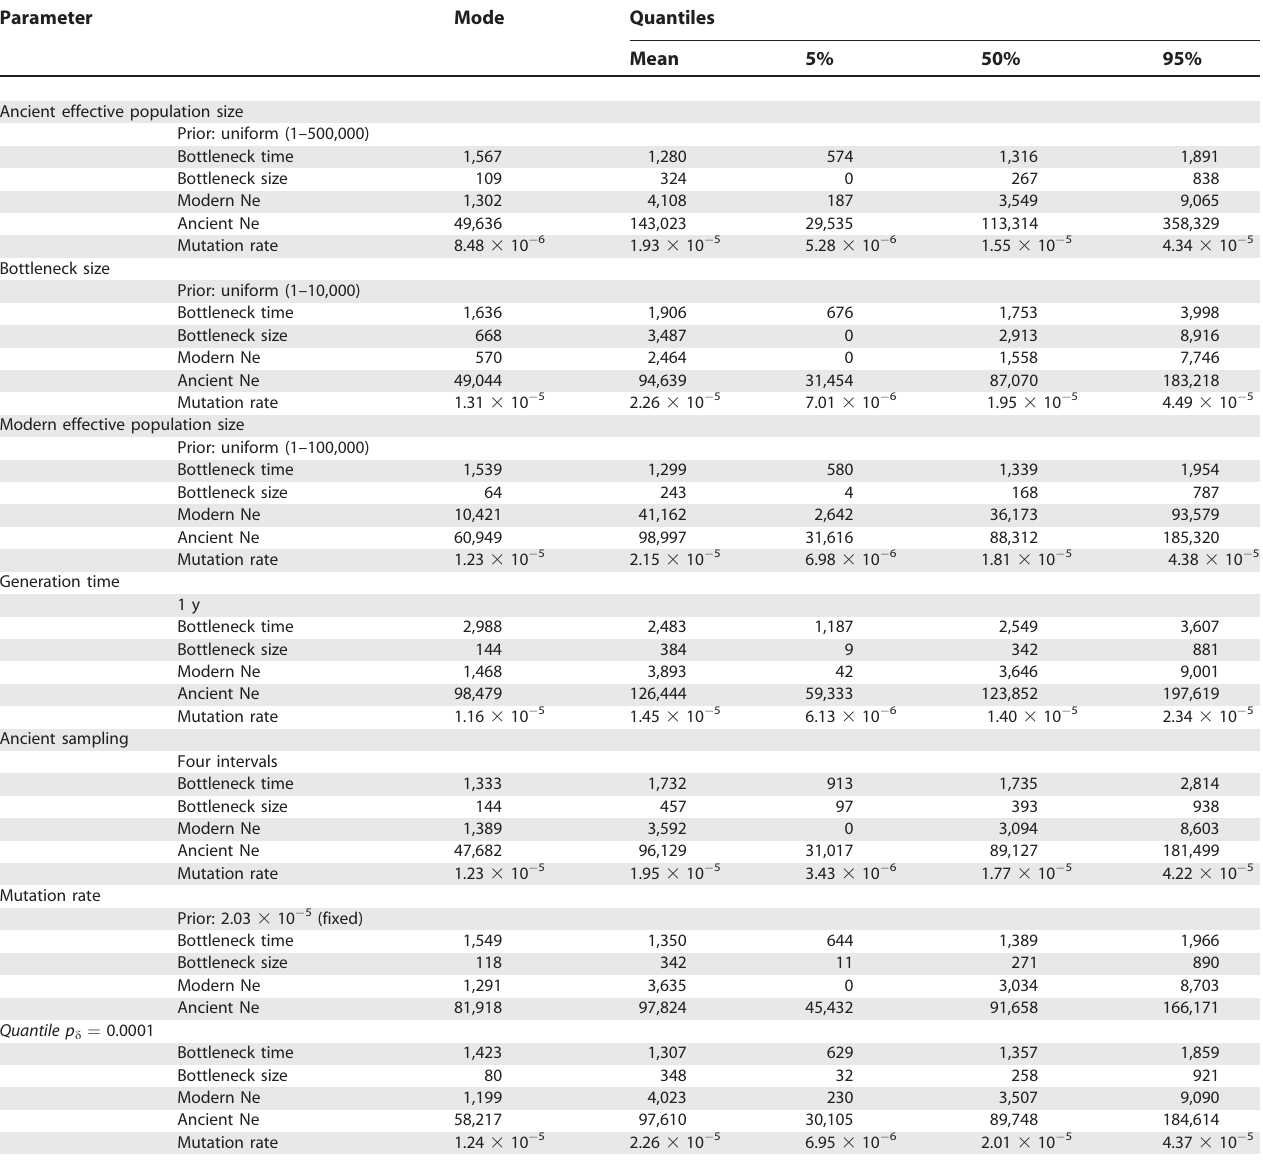
Table 2. Simulation Results Testing the Sensitivity of Demographic Inferences to Changes in Marker and Demographic Priors for C. sociabilis over 10,000 y